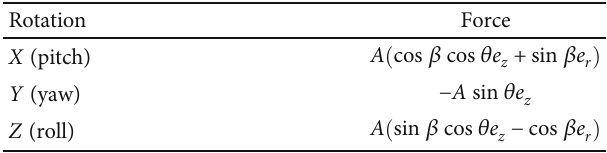
Figure 7: (a) Di ff erent rotations of the fl y. (b) Position “ P ” of the haltere in the fl apping plane ( xy ). (c) An approximate model of the haltere. Table 1: Coriolis forces for the pitch, yaw, and roll